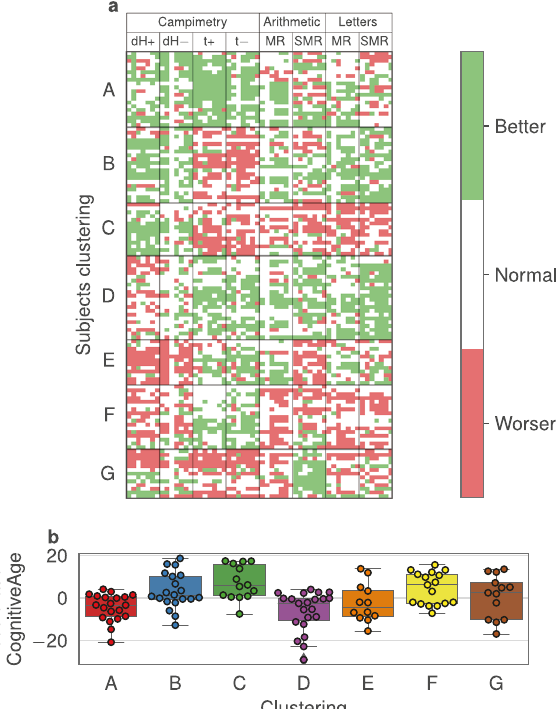
Fig. 6 Grouping subjects by similarity of cognitive test results. Rows of the table ( a ) correspond to subjects, columns correspond to cognitive test quanti fi ers, colors describes the performance of participant relative to others close in age: green — performance is better than average by half SD, red — performance is worse than average by half SD, white — performance like an average. A – G is labels of identi fi ed groups. The bottom b shows cognitive age acceleration changes in corresponding